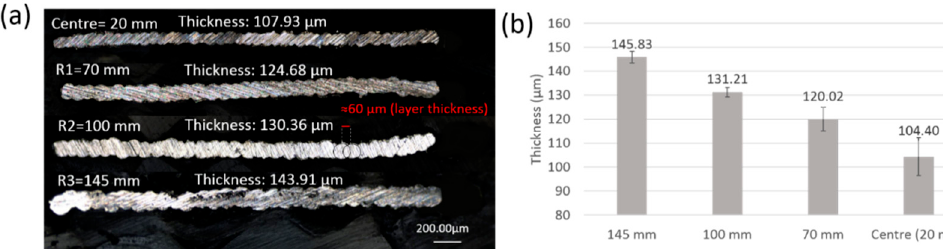
Figure 8. Analysis of the thin walls manufactured at 45 ◦ : ( a ) Measurements of wall thickness for test